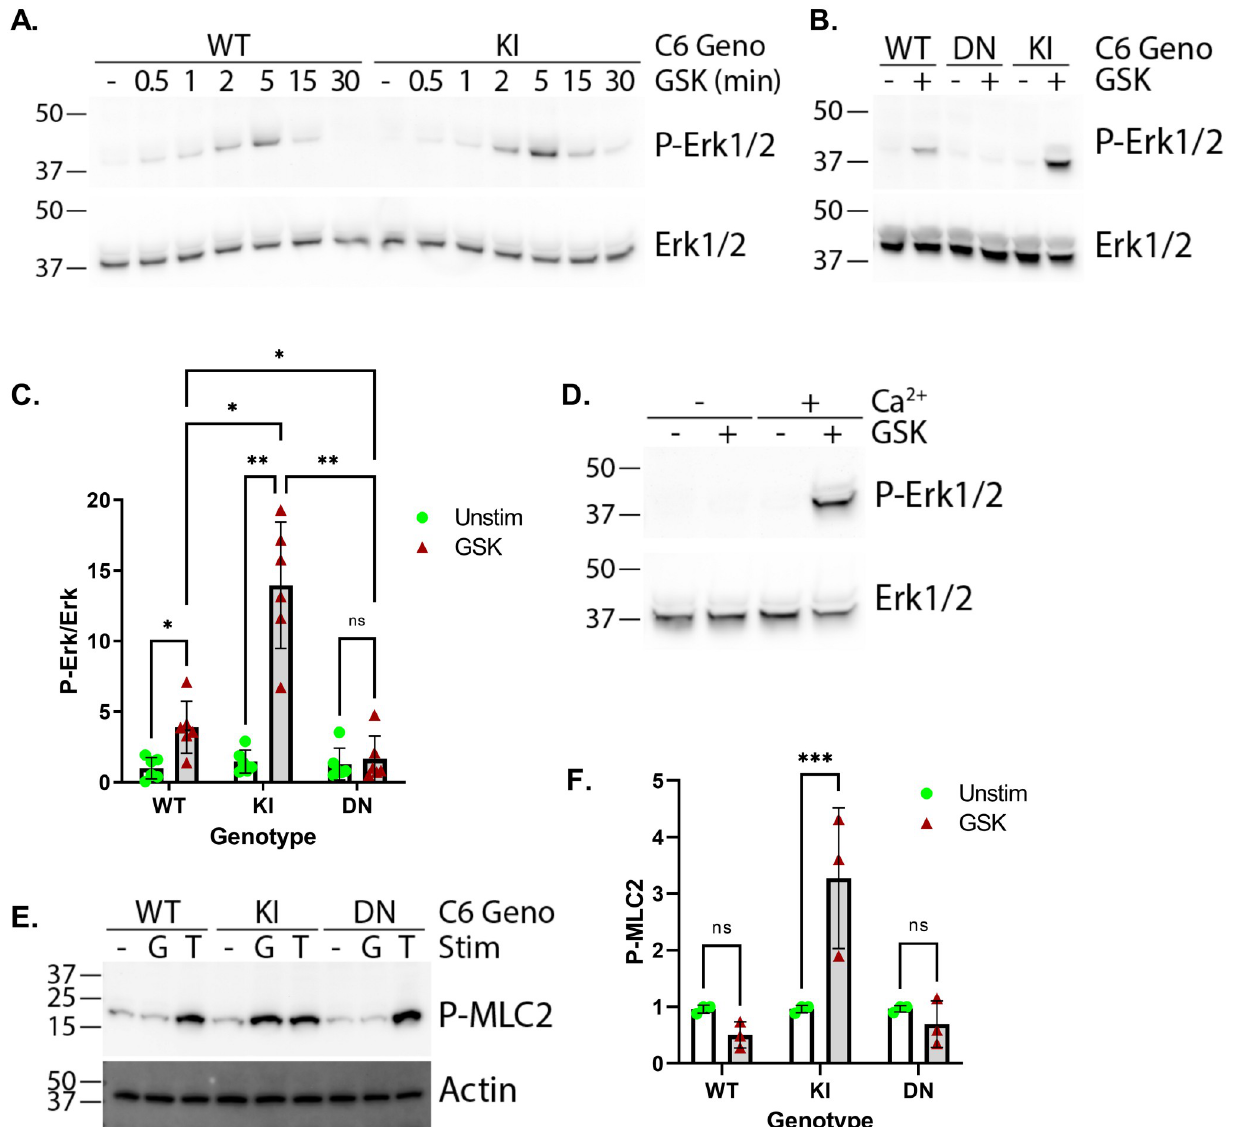
Fig 4. Trpc6 mutations differentially affect Erk1/2 and MLC2 phosphorylation in platelets. Western blot analysis of platelet lysates from various Trpc6 mice stimulated with or without GSK as indicated. A, time-course of phospho-Erk1/2 levels in WT and KI platelets after stimulation with GSK for the indicated time. Total Erk1/2 levels were utilized as loading controls (bottom panel). B, western blot for phospho-Erk1/2 (top) and total Erk (bottom) in platelet lysates from the indicated Trpc6 genotype, treated with GSK or vehicle for 5 minutes prior to lysis. C, quantification of P-Erk1/2 to Erk ratios from western blot analysis; n = 6 per group. Two-way ANOVA with Sidak’s multiple comparisons test. D, western blot of KI platelets treated with or without GSK in the absence or presence of extracellular calcium. E, phospho-MLC2 (Ser19) blot of platelets unstimulated (-), or stimulated with GSK (G) or thrombin (T) for 5 minutes. Actin served as a loading control. F, quantification of phospho-MLC2 (Ser19) levels after 5 minutes of GSK stimulation; n = 3. Two-way ANOVA with Sidak’s multiple comparisons test.